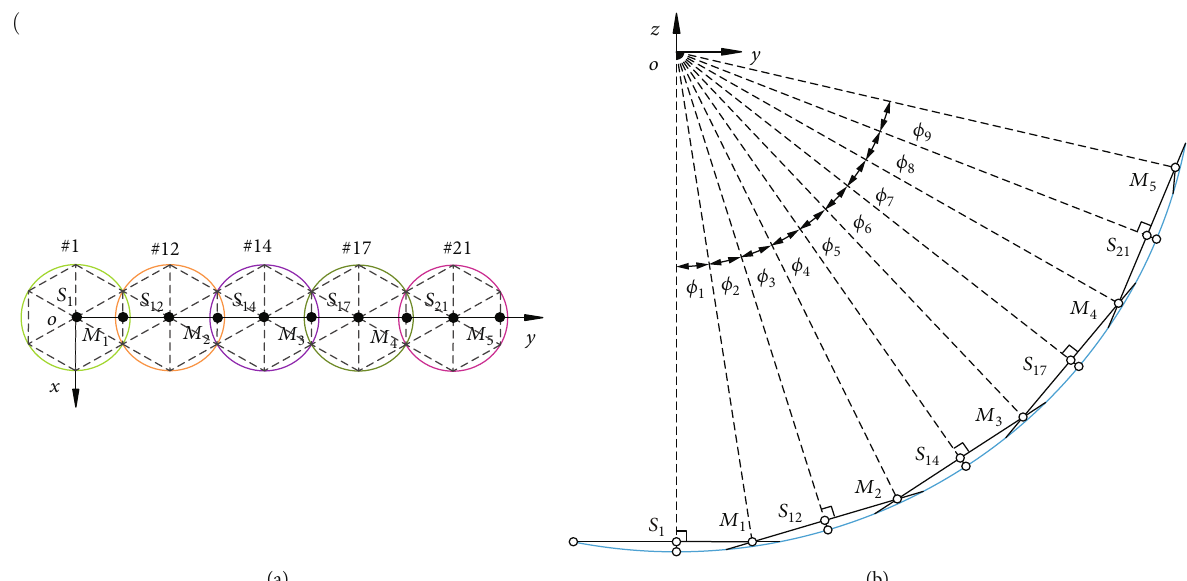
Figure 17: Positional relationships of several envelope circles: (a) xoy view and (b) yoz view.